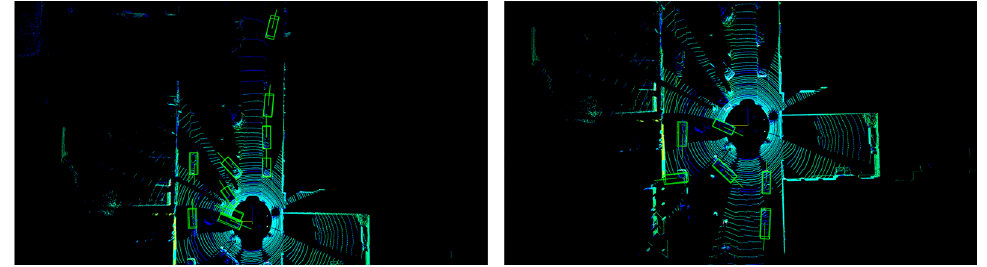
Figure 8. The broad detection results from PointRCNN.